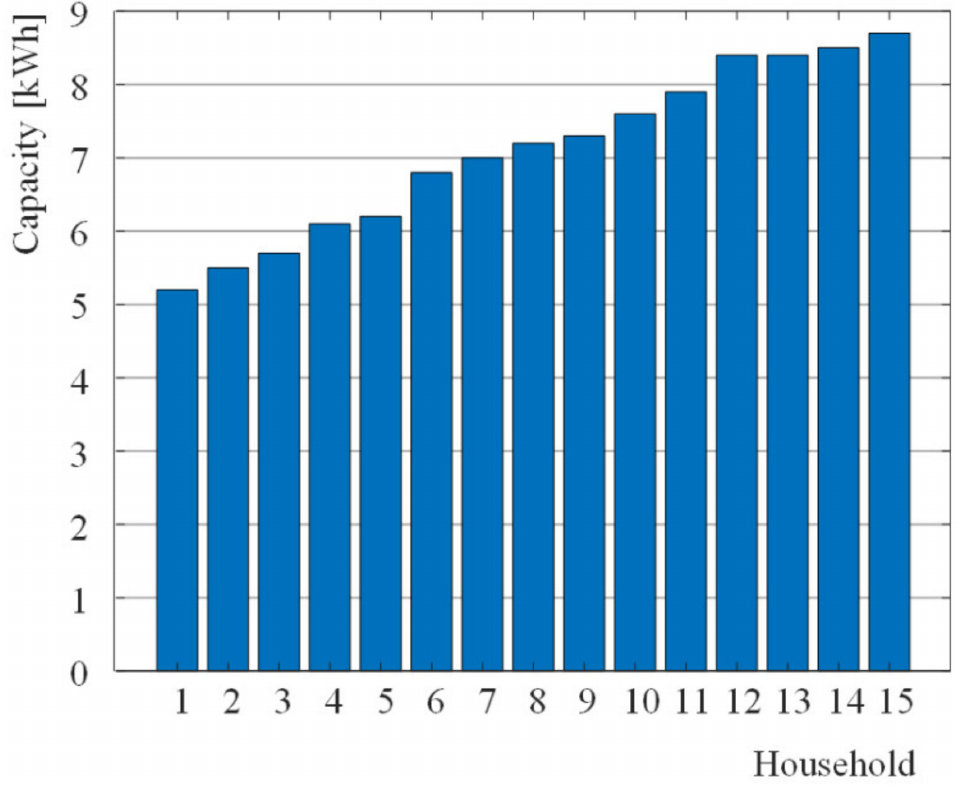
Figure 21. Battery capacity needed to reduce the power peak by 1.9